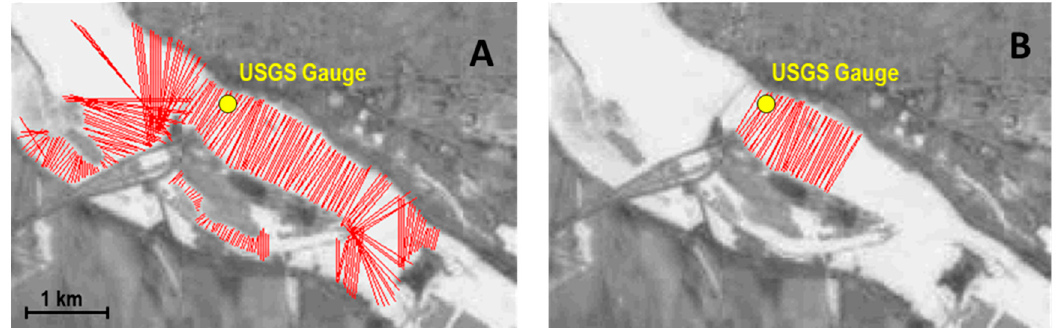
Figure 3. An example of filtering of river widths at Alton, IL, using a Landsat 5 image captured on 16 June 1984. ( A ) Raw width outputs obtained from RivWidthCloud. ( B ) Filtered widths within a ~1-km distance from a USGS gauge location.